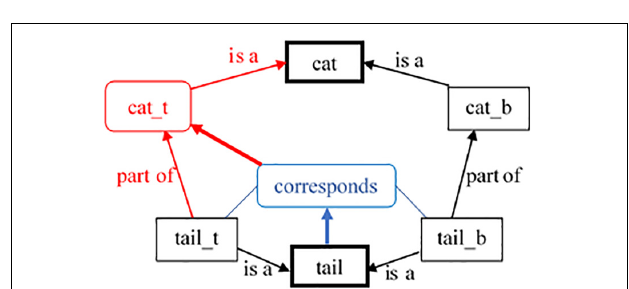
FIGURE 4 | Illustration of mapping agents (in blue) and anticipation agents (in red) in the RoleMap model. The correspondence (mapping agent in blue) agent has the concept tail (the lower bold rectangle) as justification (pointed by the bold blue arrow). The mapping itself is a justification (bold red arrow) for the anticipation agent cat_t (marked in